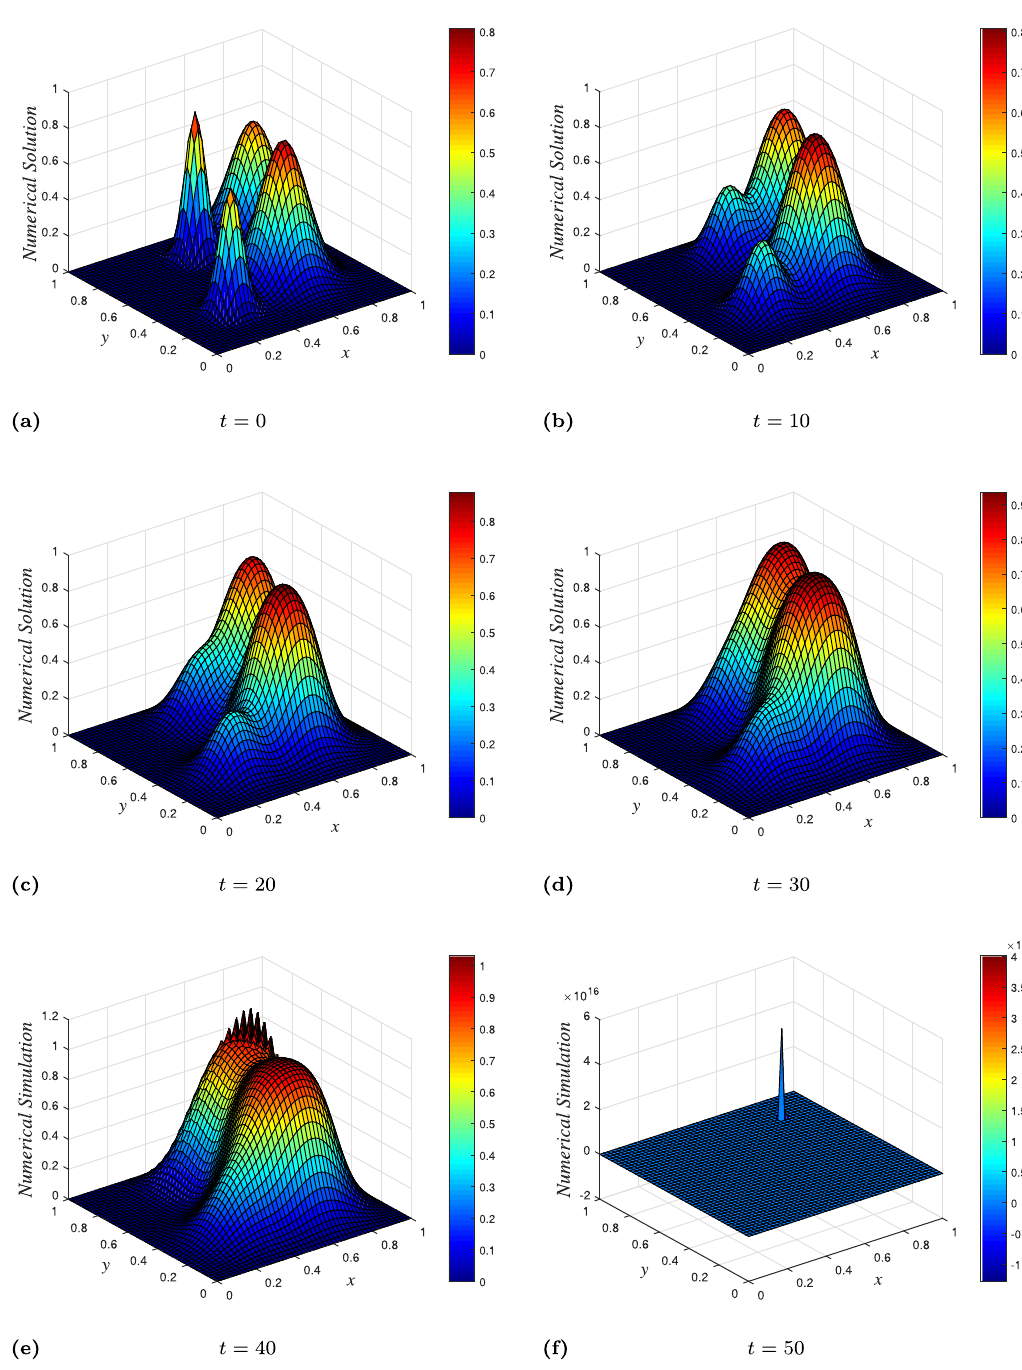
Figure 3: Plot of numerical solution vs x vs y using classical scheme at times = t 0, 10, 20, 30, 40 , and 50 with spatial step sizes = = h h 0.02 x y and time - step = k 0.55 . ( a ) = t 0 . ( b ) = t 10 . ( c ) = t 20 . ( d ) = t 30 . ( e ) = t 40 . ( f ) = t 50